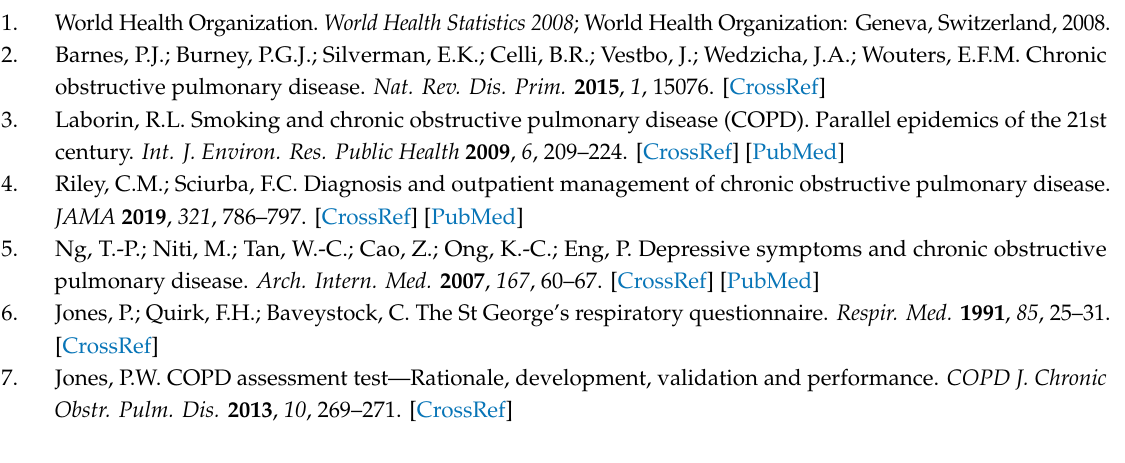
Figure S1: Goodness-of-fit plot of the SReFT analysis with final model for visual predictive check. Figure S2: Appropriateness check of SReFT analysis by using virtual data, Figure S3: Check of initial placebo e ff ect. Table S1: Summary of the properties of biomarker data classified by adopted covariates, Source code of